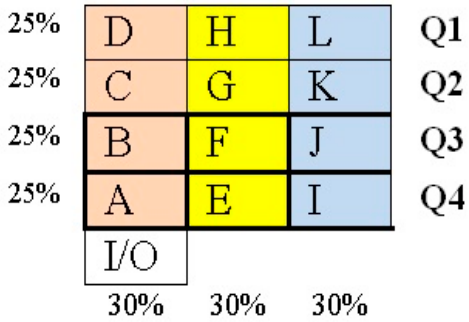
Figure 8. Illustrative classification for locations, as distributed in Table 9.